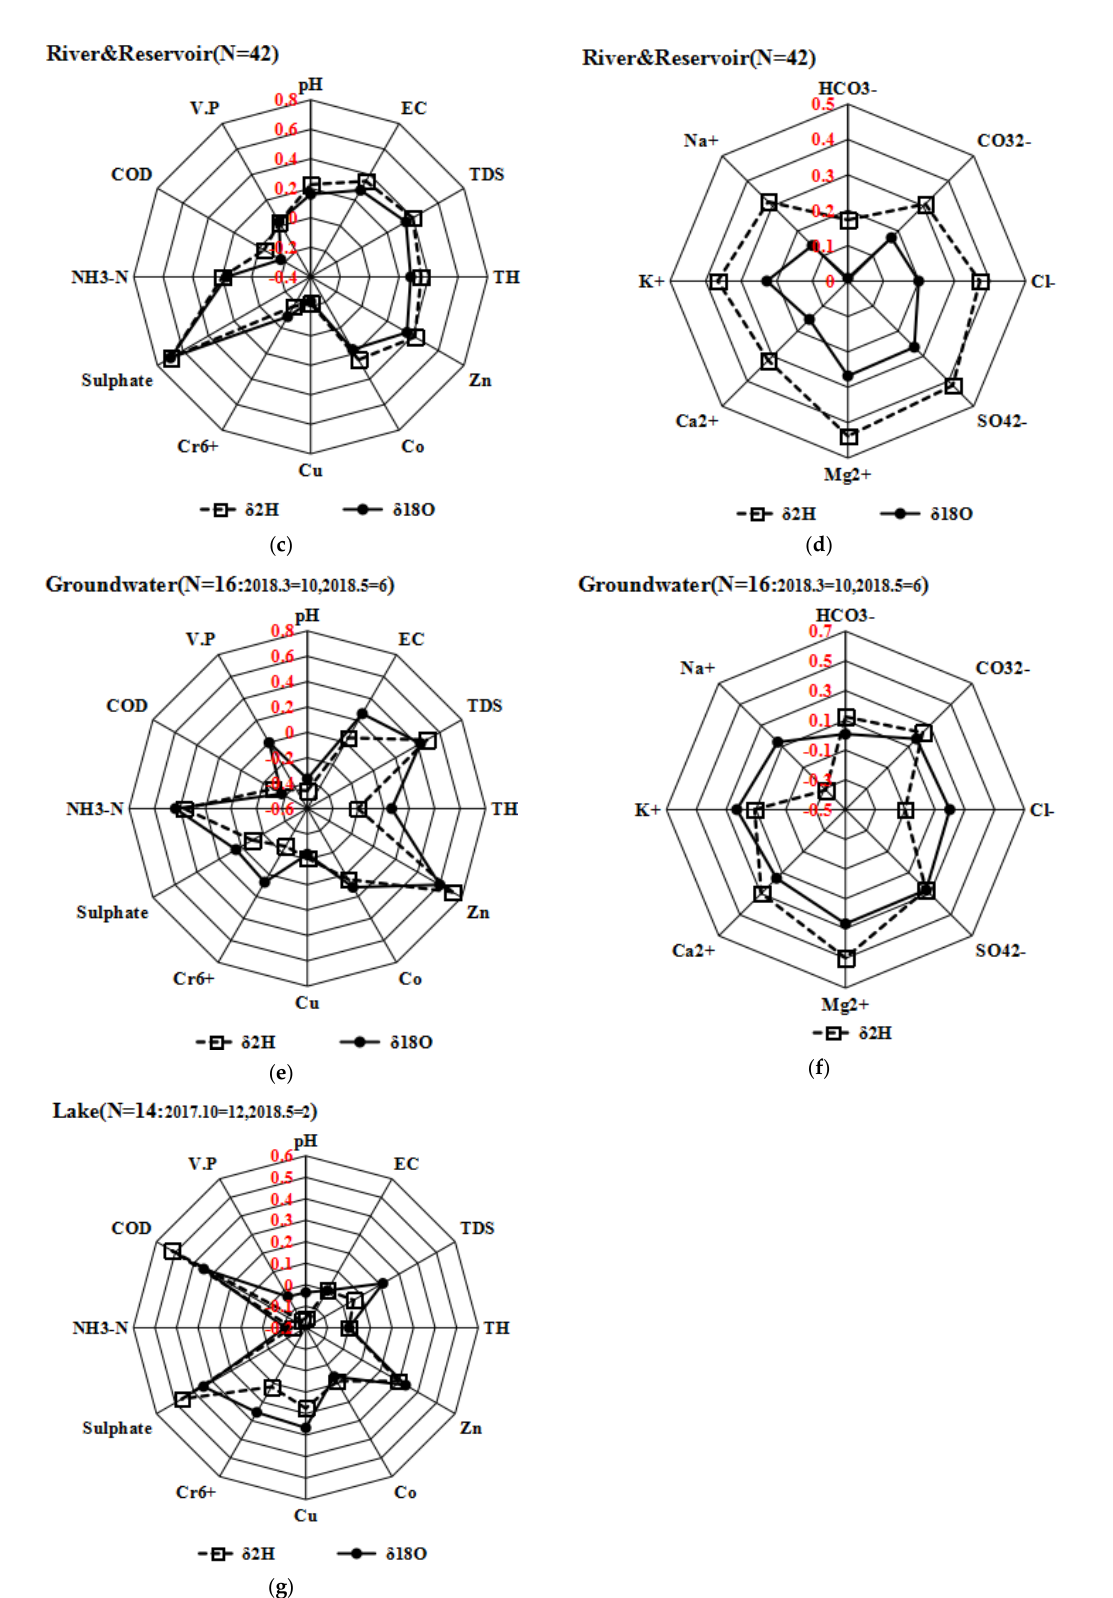
Figure 14. The correlation between hydrogen and oxygen isotopes and water quality parameters (( a ): all; ( c ): river and reservoir; ( e ): groundwater; ( g ): lake) and eight anions (( b ): all; ( d ): river and reservoir; ( f ): groundwater; lake). No data were available in October 2017.